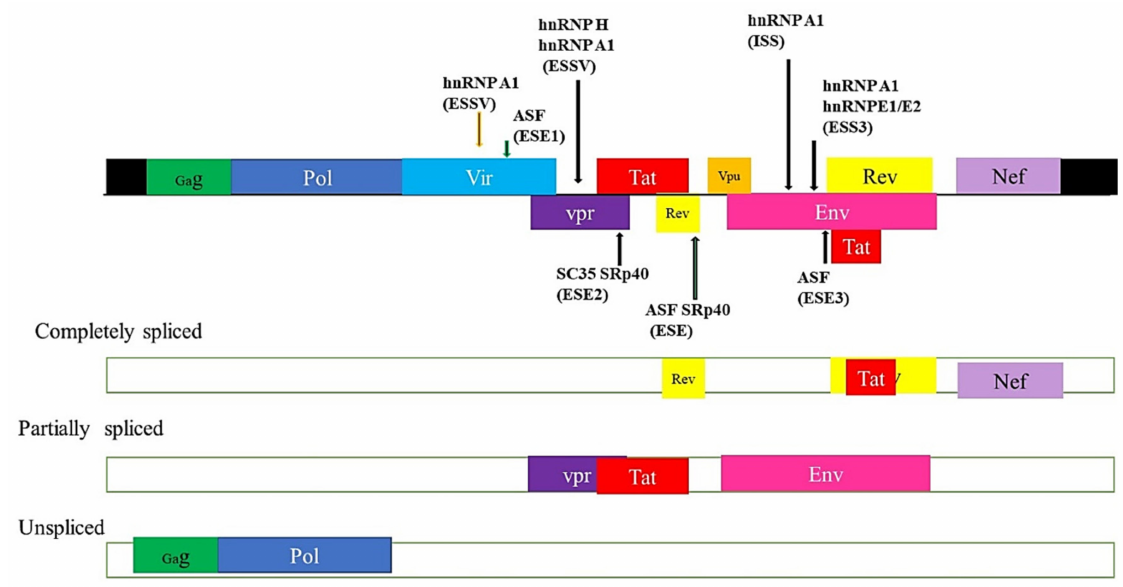
Figure 5. Splicing of the HIV genome. In the early stage of HIV infection, tat, rev and nef regulatory proteins are transcribed from completely spliced mRNA. Additionally, following early infection, vif, vpr, vpu and env are transcribed from partially spliced mRNA. Furthermore, non-spliced mRNA is translated to form the gal and pol structural